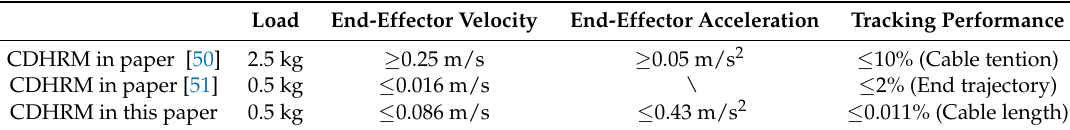
Table 4. Experiment data comparison between different